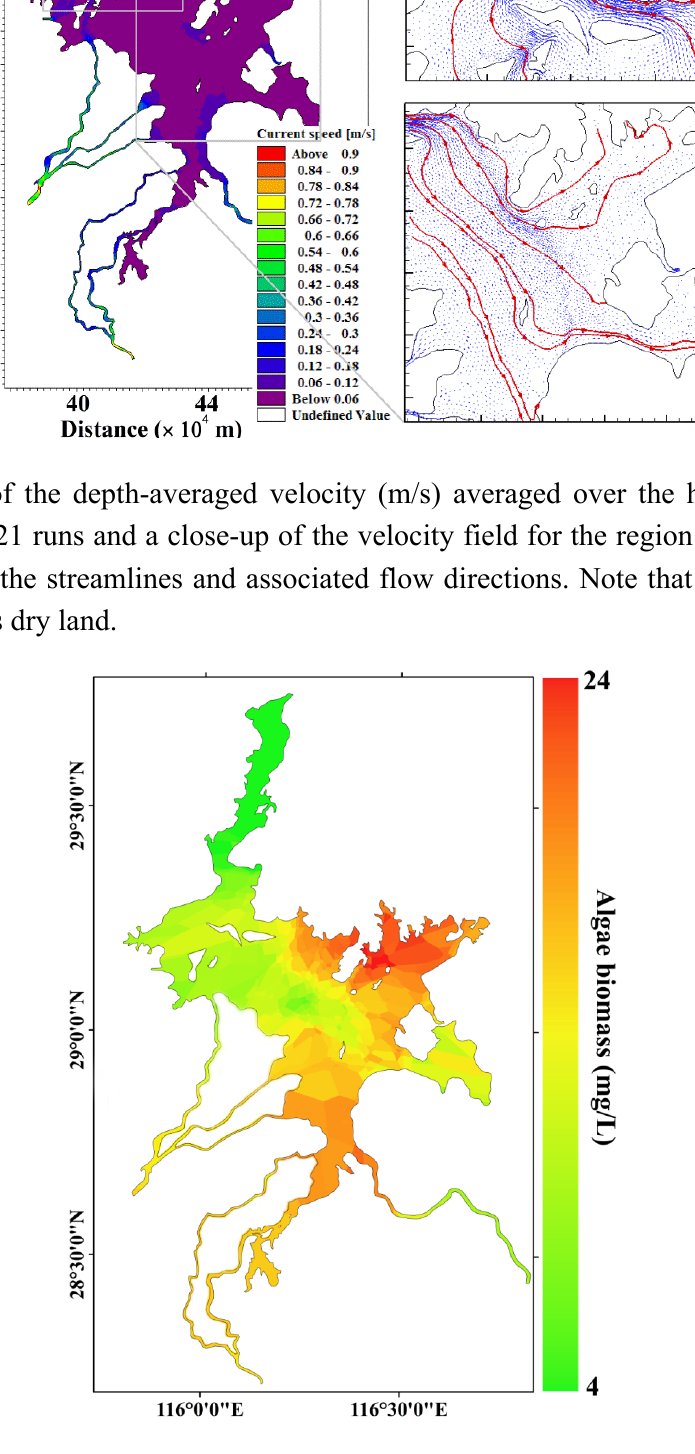
Figure 9. Spatial distribution of algae biomass (in mg/L) in Poyang Lake. Algae biomass data were obtained from 83 field samplings in July